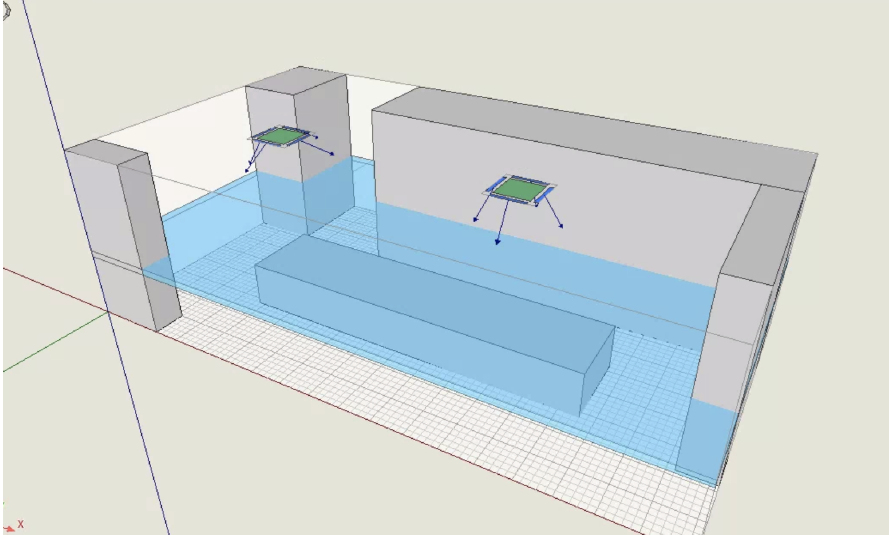
Figure 3. Small room with two air conditioners under the